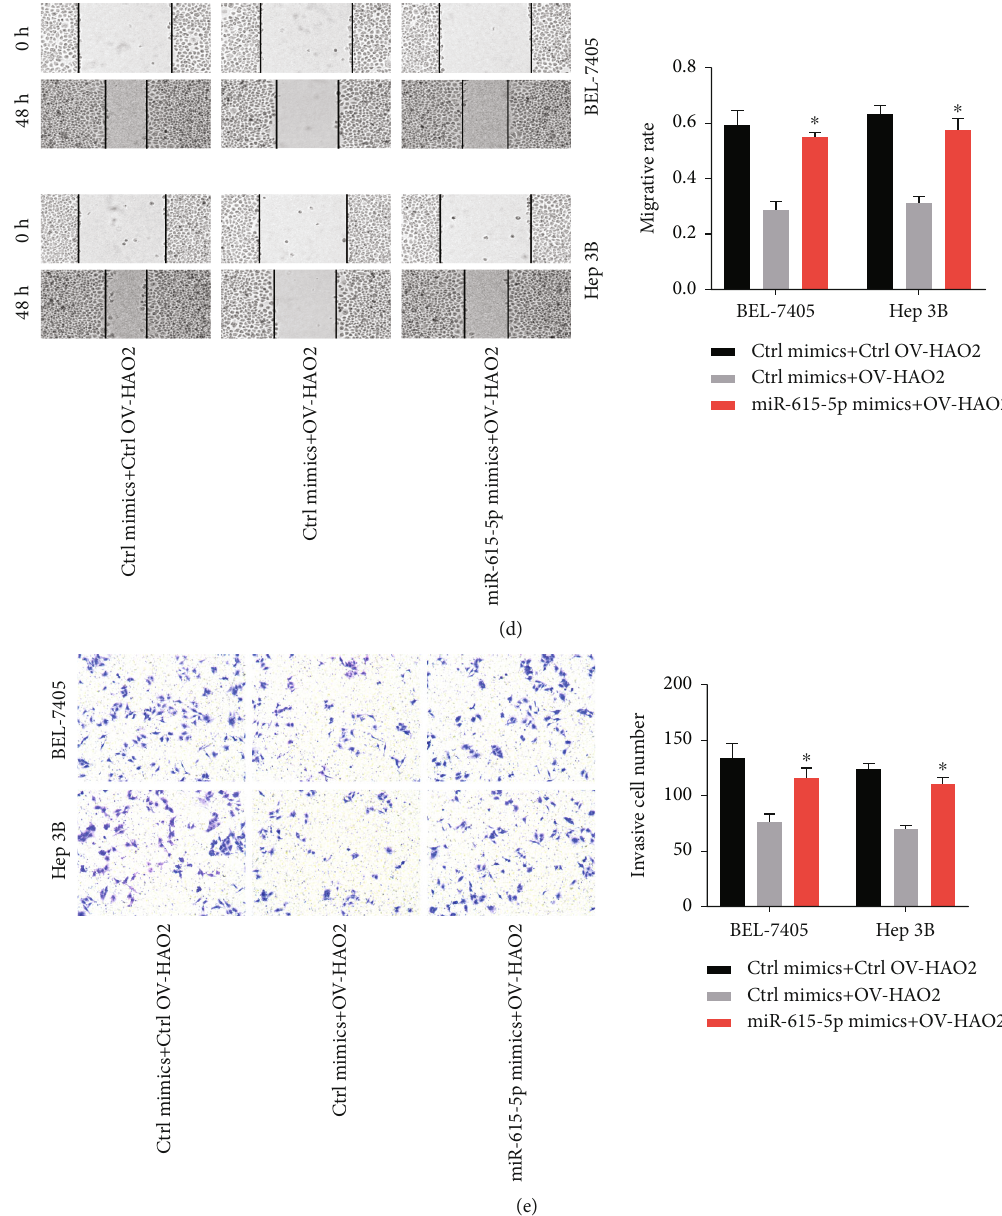
Figure 4: miR-615-5p recues the biological function of HAO2 in HCC cells. (a – c) The proliferation ability was evaluated by CCK-8 cell assay (a), colony formation assay (b), and Edu incorporation assay (c). (d) The migration ability was assessed by wound healing assay. (e) The invasion ability was determined by the Transwell assay. ∗ P < 0 : 05